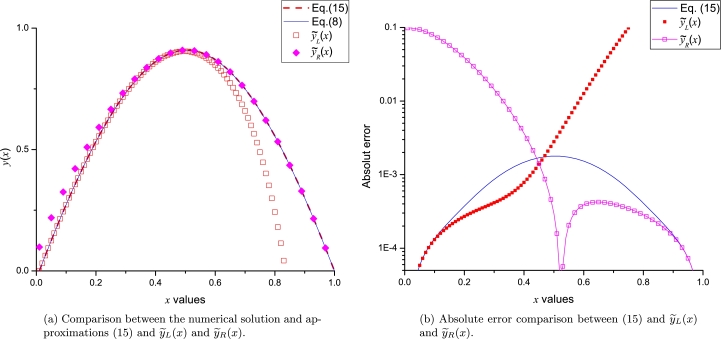
Comparison between LP (15) and Taylor series (16).